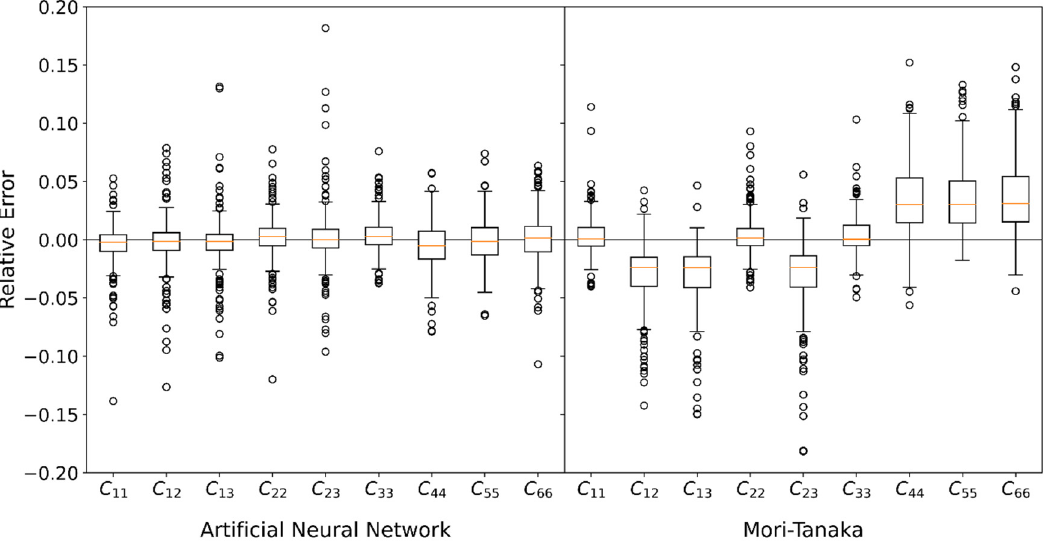
Figure 8. Boxplot of relative Error by NN and MT.